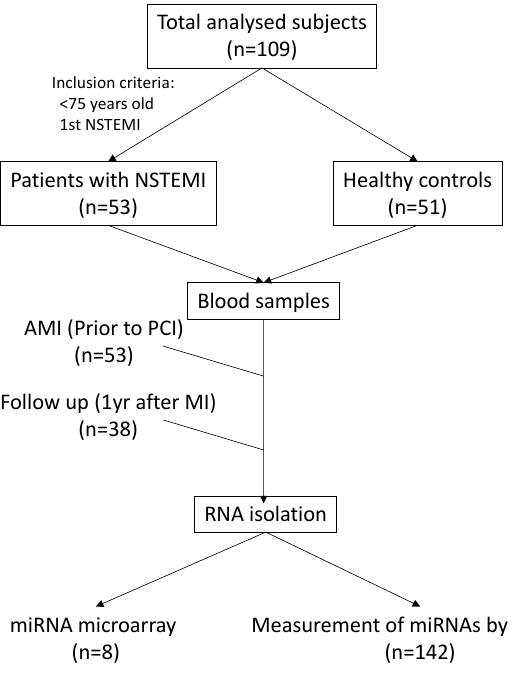
Figure 1. Study design and